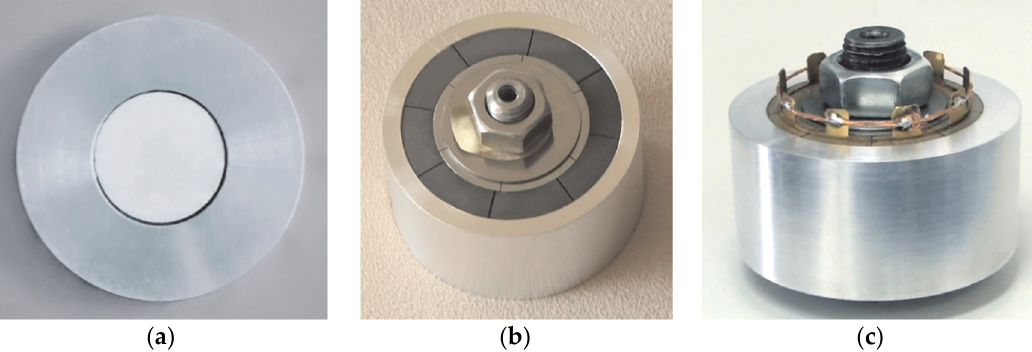
Figure 33. Three radial piezoelectric ultrasonic transducers. ( a ) Radial discs. ( b ) Radial cylinders. ( c ) Sandwiched rings.